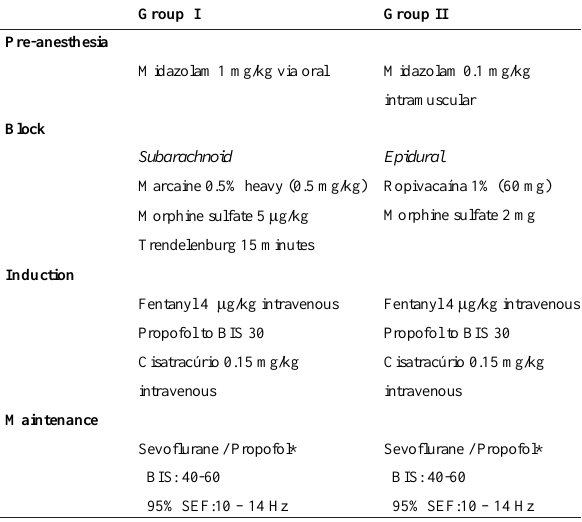
* Utilized only during